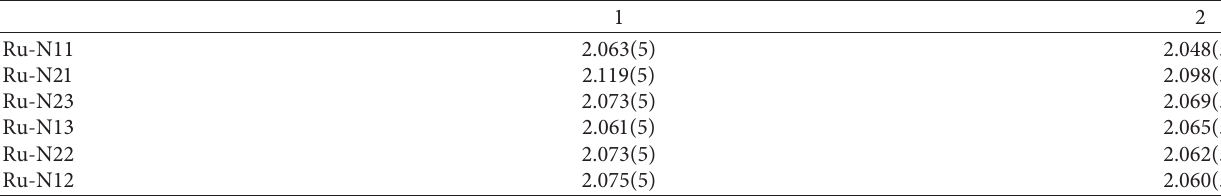
Table 5: Metal-N quinoxaline and metal-N pyridyl bond lengths